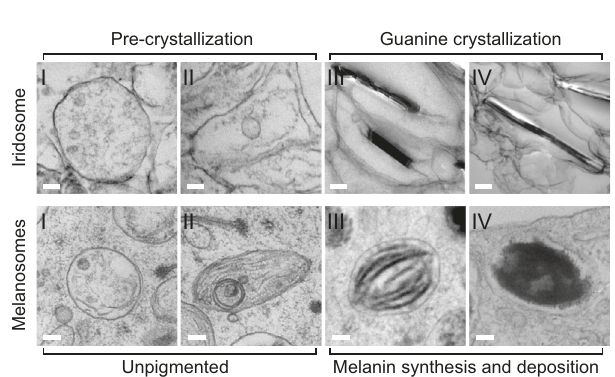
highlighted regions of interest in ( b ). c Representative in situ μ spot wide-angle X- ray diffraction (WAXS) patterns from corresponding regions of the adult mirror showing the preferred orientation of the guanine (100) peak across the mirror. Throughoutthe fi gure,thecolorscorrespondtothedifferentregionsofthemirror: yellow — left, blue — center, and pink — right. Scale bars: 200nm.